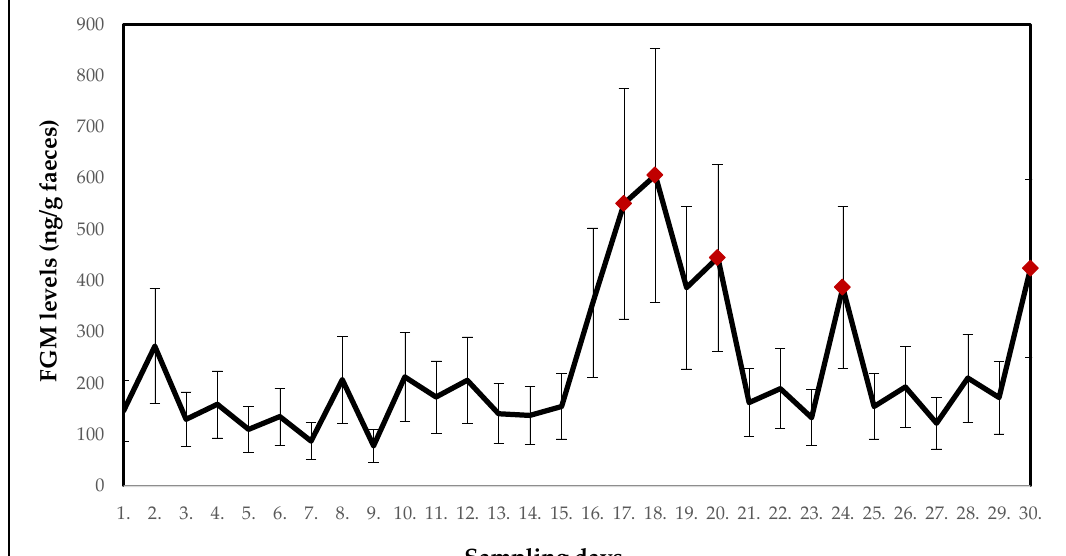
Figure 4. Mean concentrations of the faecal glucocorticoid metabolites (FGMs) in collared brown lemurs with significant increases compared to the first day of sampling indicated. Red points indicate a significant increase in FGM levels.